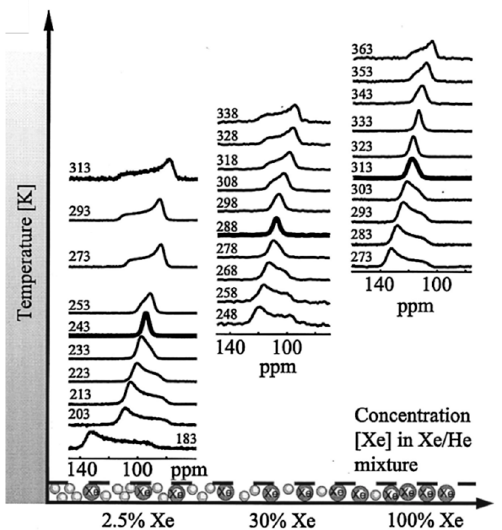
Figure 13. CF HP 129 Xe NMR line shapes for Xe inside tris-( o -phenylenedioxy)cyclotriphosphazene channels at different temperatures and xenon concentrations. All spectra were acquired at ambient pressure. Adapted with permission from reference [128]. Copyright 2000 American Chemical Society.